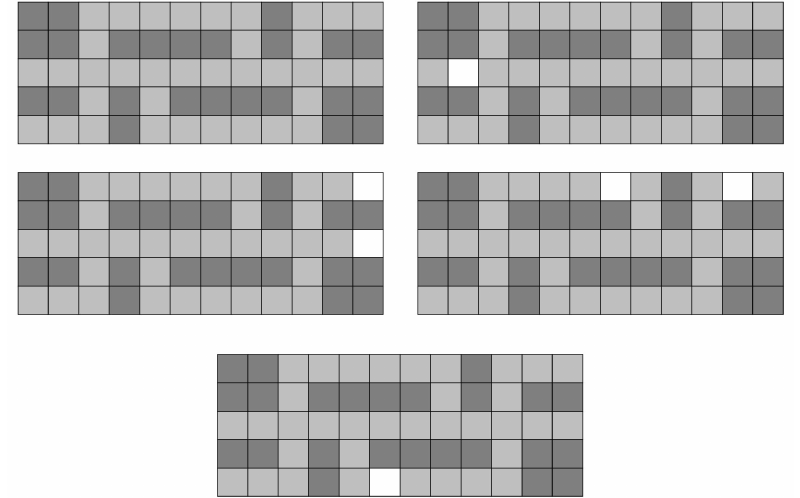
Figure 4. The channels of the proposed image-like state